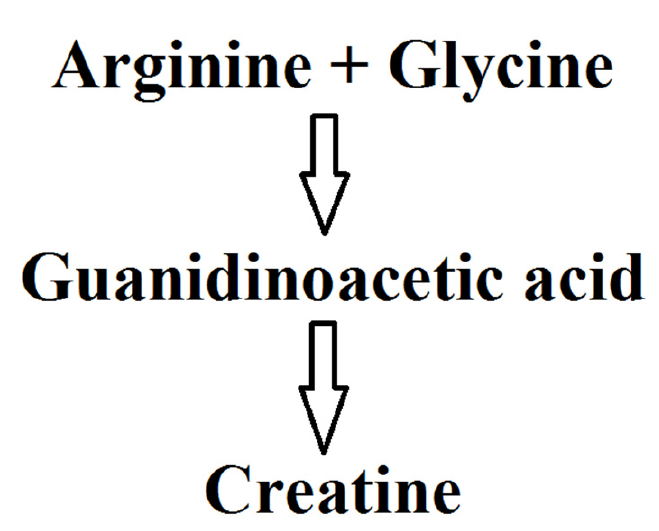
Figure 1. Endogenous synthesis of creatine, simplified scheme. See text for more details.